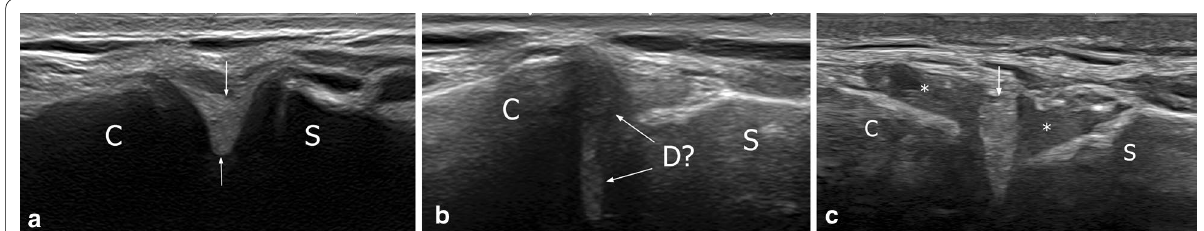
Fig. 4 Intra-articular disc (upward and outward oblique transverse plane). a In this patient, the disc was clearly seen (arrows) as a hyperechoic triangular structure in the joint. b In this other patient with the arm alongside the body, the depiction of the disc was less clear. Moreover, intra-articular gas bubbles were associated (arrows). c With antepulsion of the shoulder, the joint fluid (*) and intra-articular disc (arrow) were displaced anteriorly, improving analysis of the disc. C: clavicle, S: sternum